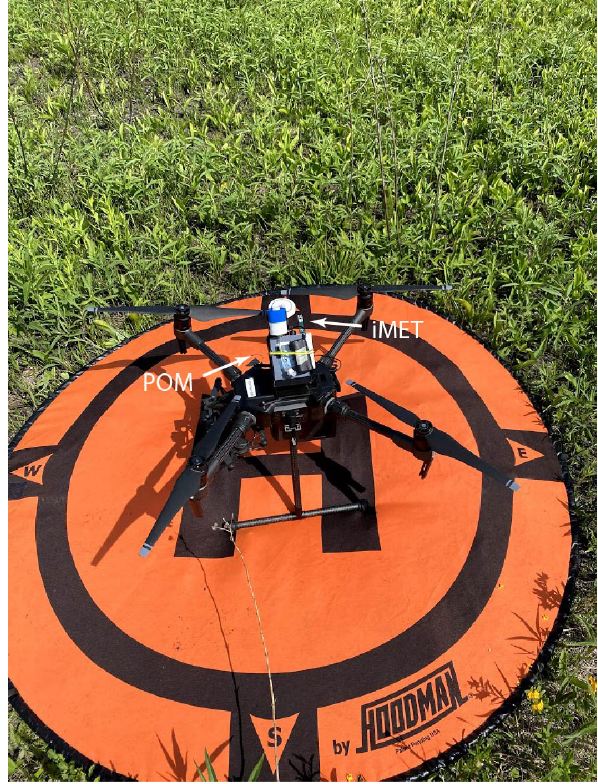
Figure 2. DJI M210 multirotor UAS with bracket-mounted POM and